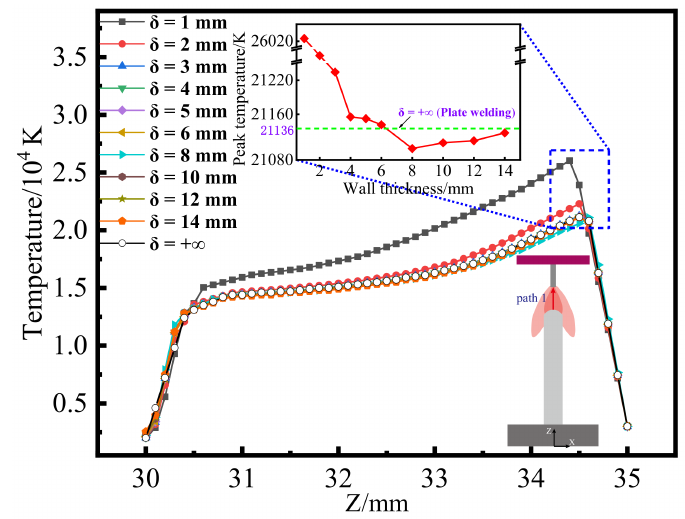
Figure 5. Temperature distribution curves along path 1 with different wall thicknesses.